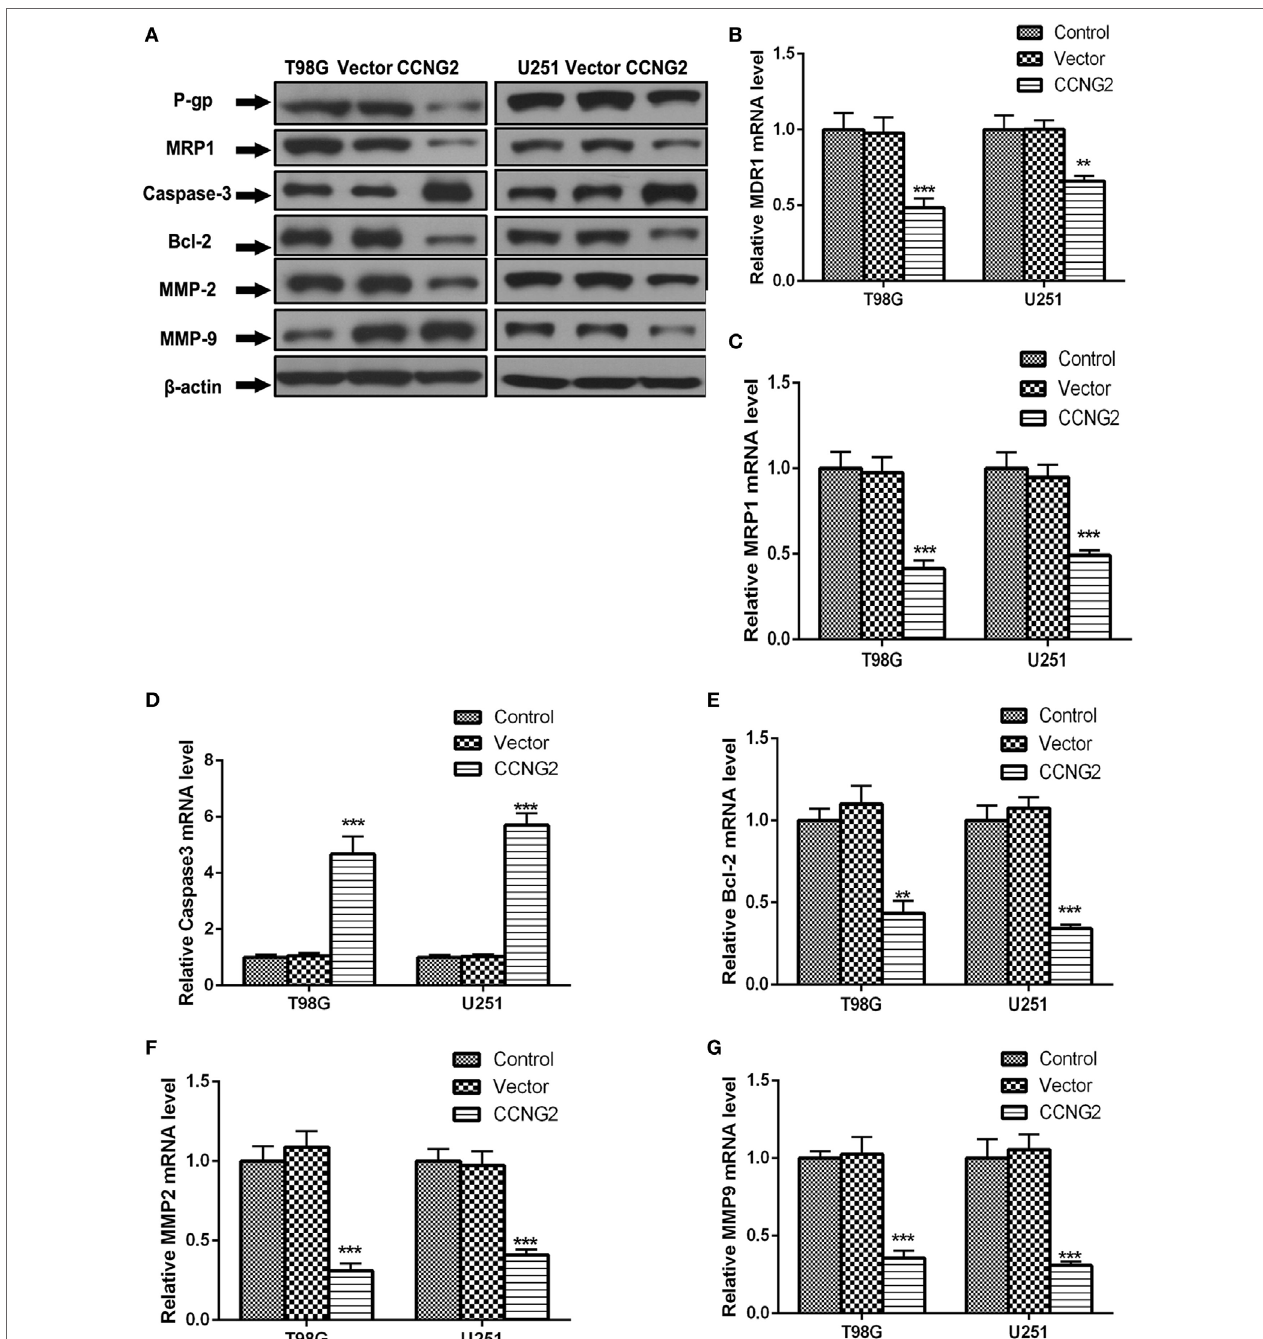
FigUre 4 | Effect of overexpressed CCNG2 on protein and mRNA expression of MDR1 (P-gp), MRP1, Bcl-2, caspase-3, MMP-2, and MMP-9 in T98G and U251 cells. (a–g) Western blot and RT-PCR analysis the protein and mRNA levels of MDR1 (P-gp), MRP1, caspase-3, Bcl-2, MMP-2, and MMP-9 in T98G and U251 cells transfected with CCNG2 or vector or control. Data were expressed as mean ± SEM ( n = 3). ** P < 0.01 and *** P <